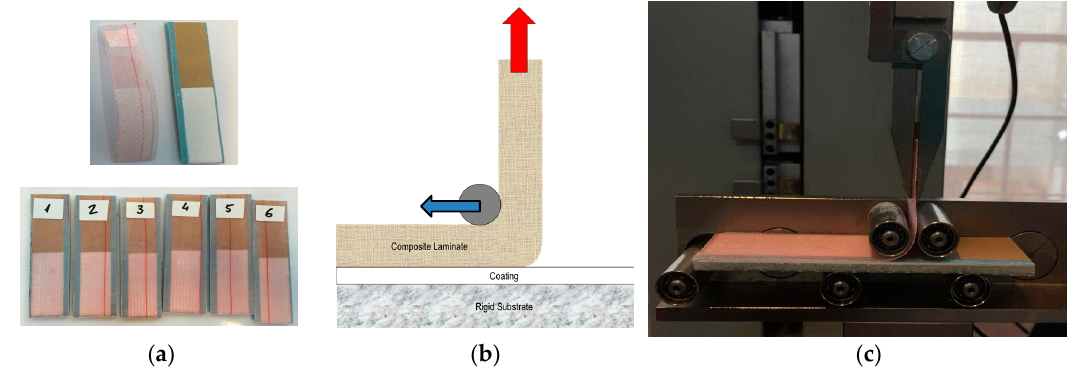
the failure in the laminate ( b ).